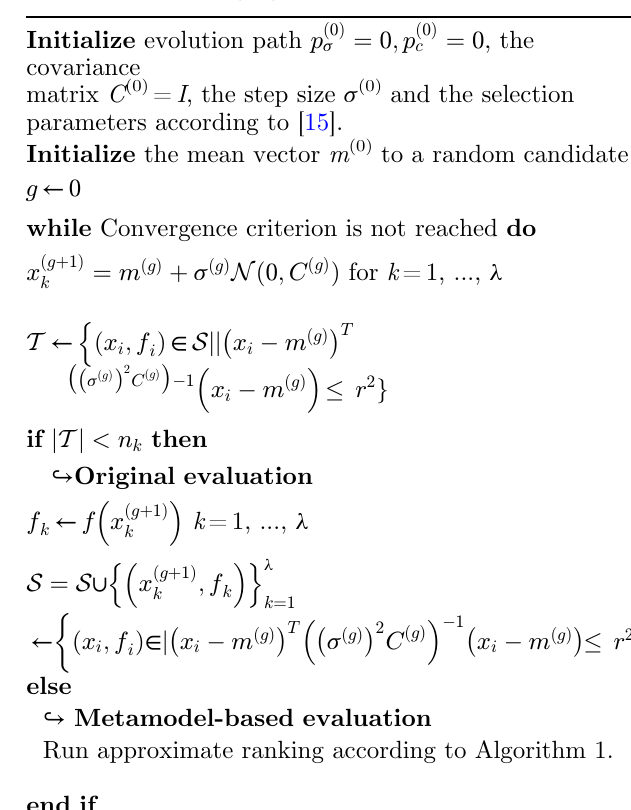
Algorithm 2. Kriging-assisted